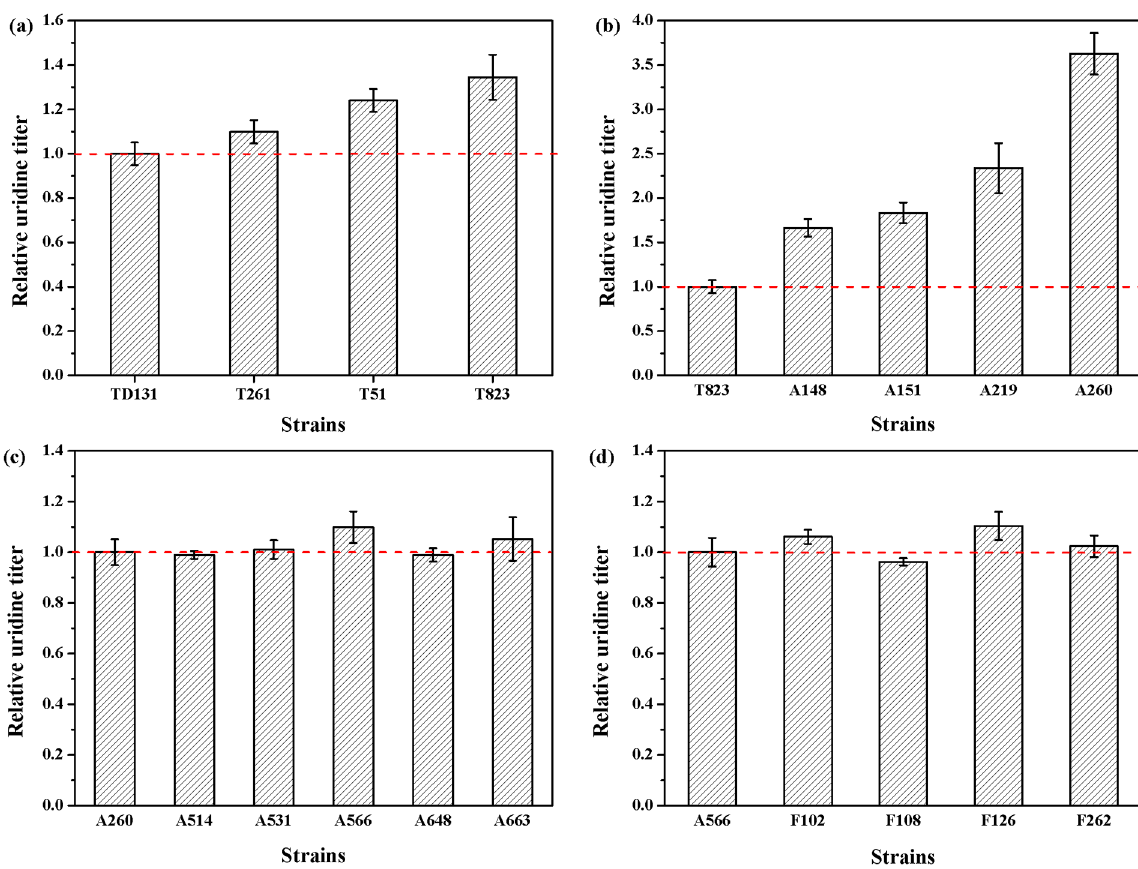
Fig 3. Relative uridine titer of representative mutants after different rounds of ARTP mutagenesis. (a) Mutants isolated from 200 mg/L, 300 mg/L and 400 mg/L 2-thiouracil-resistanceplate; (b) Mutants isolatedfrom 100 mg/L 6-azauracil-resistanceplate; (c) Mutants isolated from 3 g/L 6-azauracil-resistanceplate; (d) Mutants isolatedfrom 200 mg/L 5-fluorouracil-resistance plate.